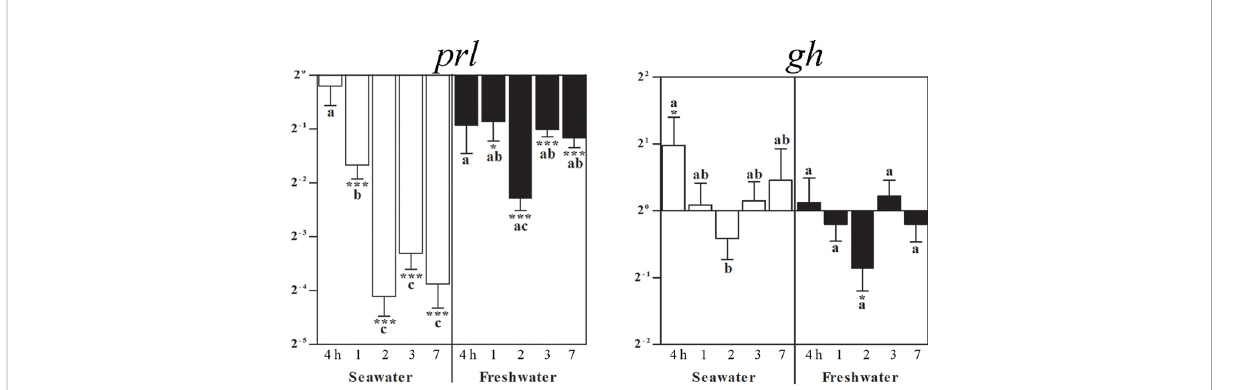
FIGURE 3 Effects of a seawater and freshwater exposure on pituitary prl and gh gene expressions. Relative changes (log 2, y-axis) of mRNA expression at 4 h, 1, 2, 3 and 7 days (x-axis) after exposure to seawater (white columns) and freshwater (black columns). Bars represent mean ratios between treated and control group ± SEM and asterisks show signi fi cant differences: * p < 0.05; *** p < 0.0005. Bars within treatment groups that do not share any letters are signi fi cantly different from each other: p < 0.05., e.g., prl seawater expression between 4 h and 1 day, 2, 3 or 7 days are signi fi cantly different, but between 2 and 3 or 7 days are not signi fi cantly different. :Starting 1 day after return of freshwater, a signi fi cant difference to untreated freshwater controls was observed, but not between time points.